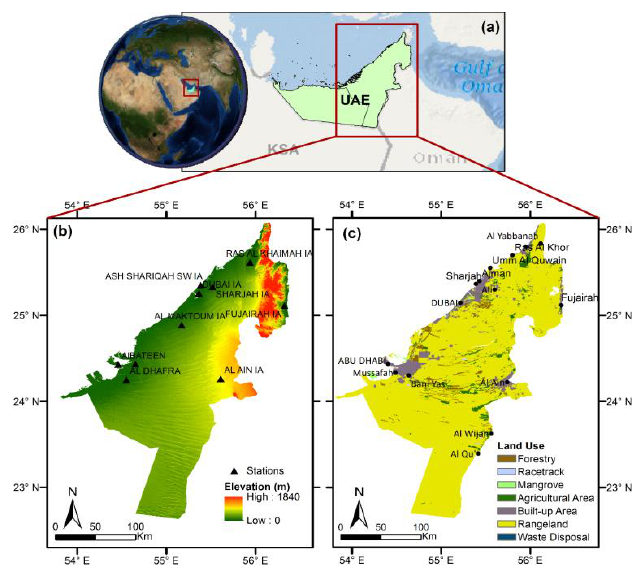
Figure 1. ( a ) Study domain; ( b ) locations of the ten stations and elevation map; and ( c ) land use map and location of major cities in the UAE.